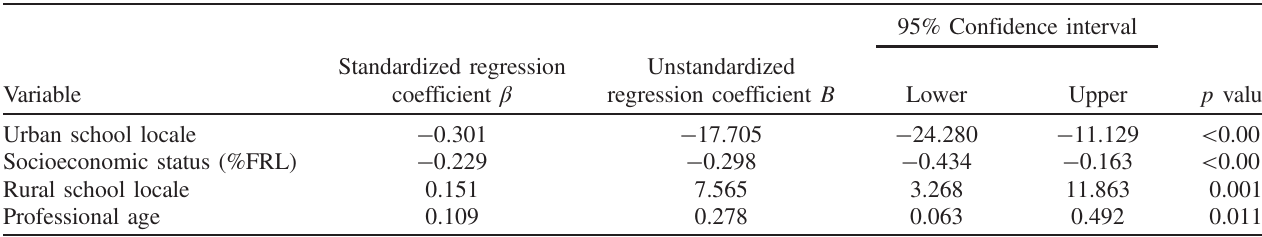
TABLE IX. Multivariable regression model.